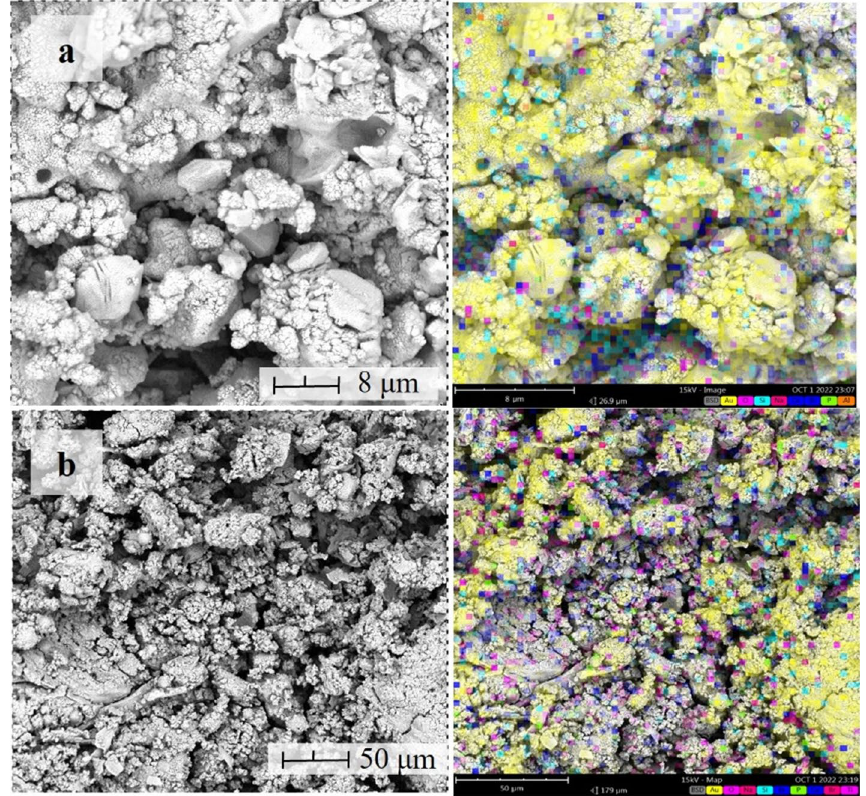
Figure 8. Morphological characteristics and elemental analysis of ( a ) GP-1 and ( b ) GP-2